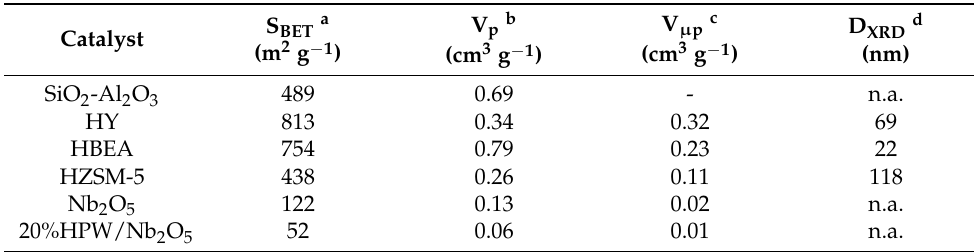
Table 2. Textural properties of catalysts obtained from N 2 adsorption/desorption isotherms at −196 °C. Catalyst